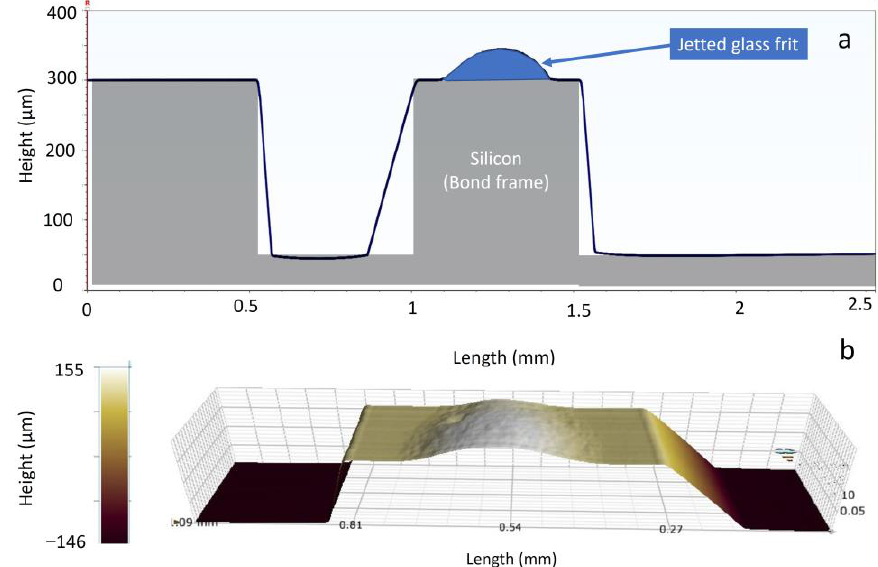
Figure 6. 2D ( a ) and 3D ( b ) profilometric graphs of the cap silicon wafer with the jetted glass frit paste.